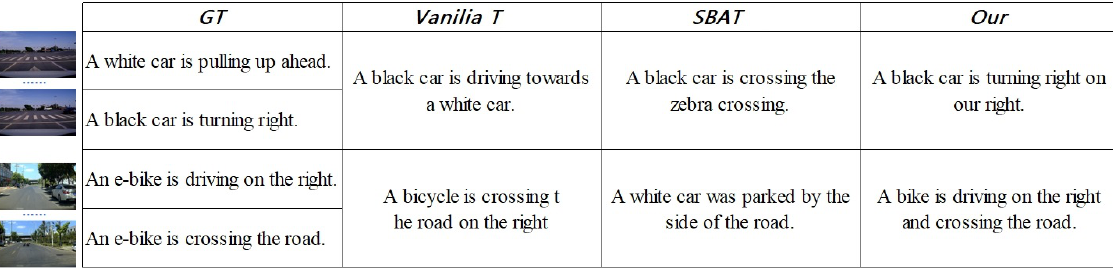
Figure 4. Video caption instance in BUUISE dataset [8,9].